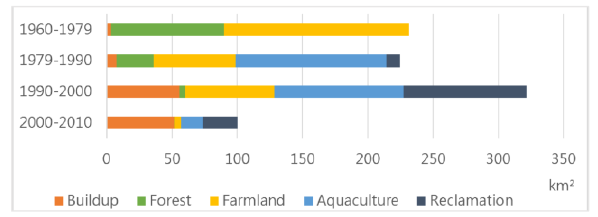
Figure 7. Landuse state in expanded